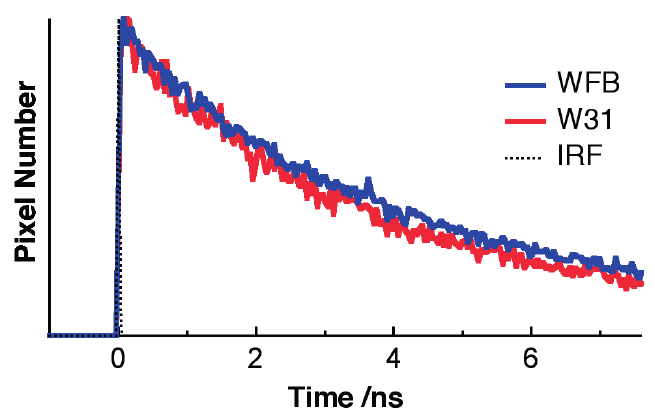
Figure 5. Representative fluorescence decays of TPS in WFB cells (blue) and in W31 cells (red). The scattered light is shown by a dotted line